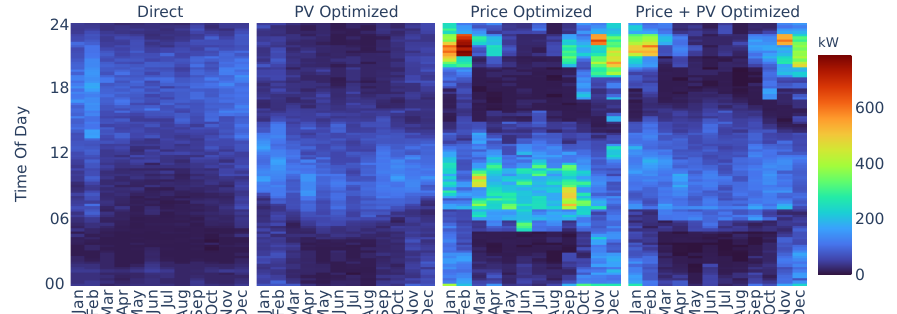
Figure 14. Aggregated maximum for EV charging power throughout the year for different charg- ing configurations.